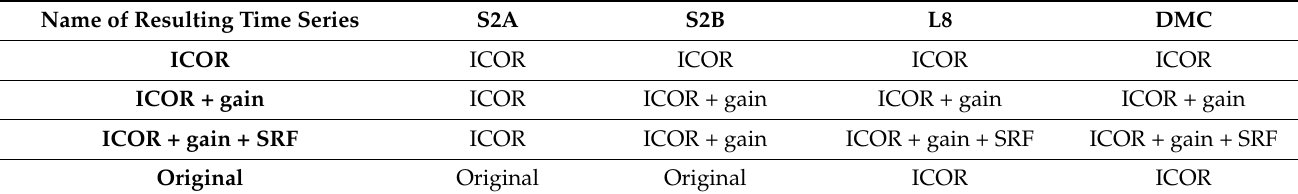
Table 3. Definition of the combined datasets extracted for the HESBANIA fields (in situ and from the parcel database).